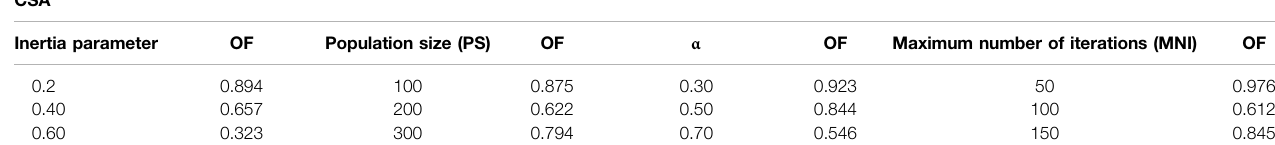
TABLE 2 | Sensitivity analysis for random parameters of optimization algorithms in Ahvaz